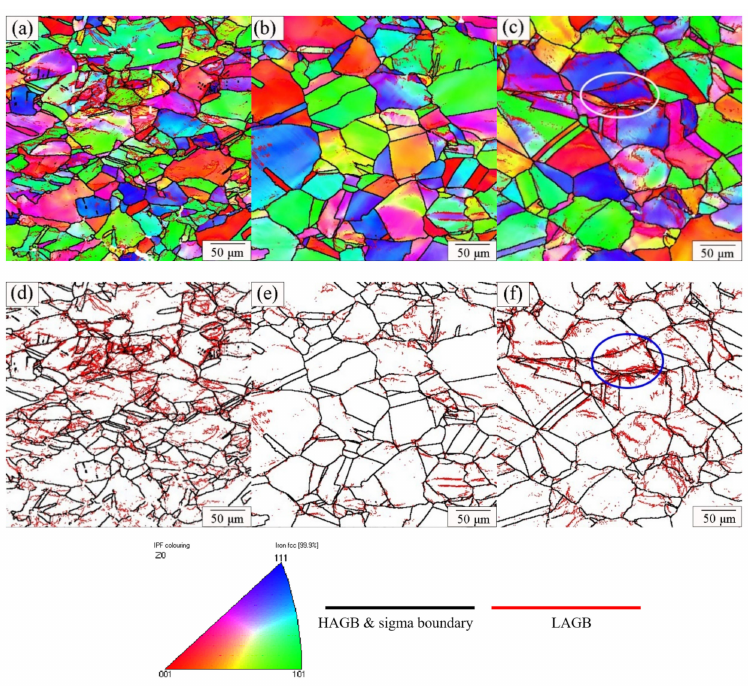
Figure 6. EBSD grain boundary maps of the specimens fabricated by the tensile deformation at ε t = 0.14: IPF maps ( a – c ) and distribution maps of grain boundary ( d – f ), 12Cr–CN ( a , d ), 19Cr–0.7N ( b , e ), 19CrSi–0.7N ( c , f ).